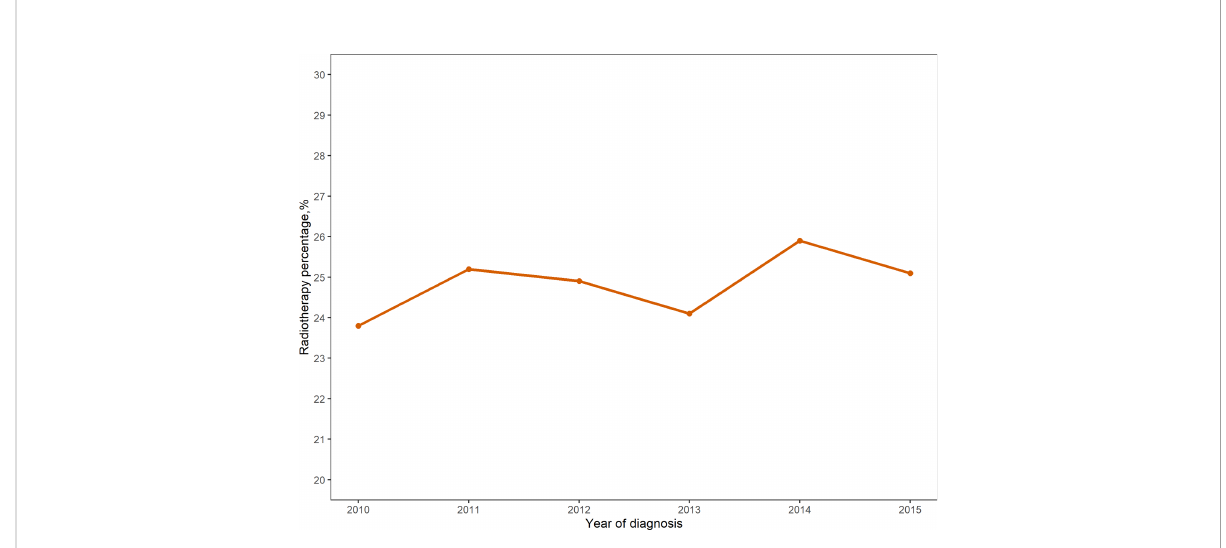
FIGURE 1 Proportion of patients undergoing immediate breast reconstruction after mastectomy receiving radiotherapy from